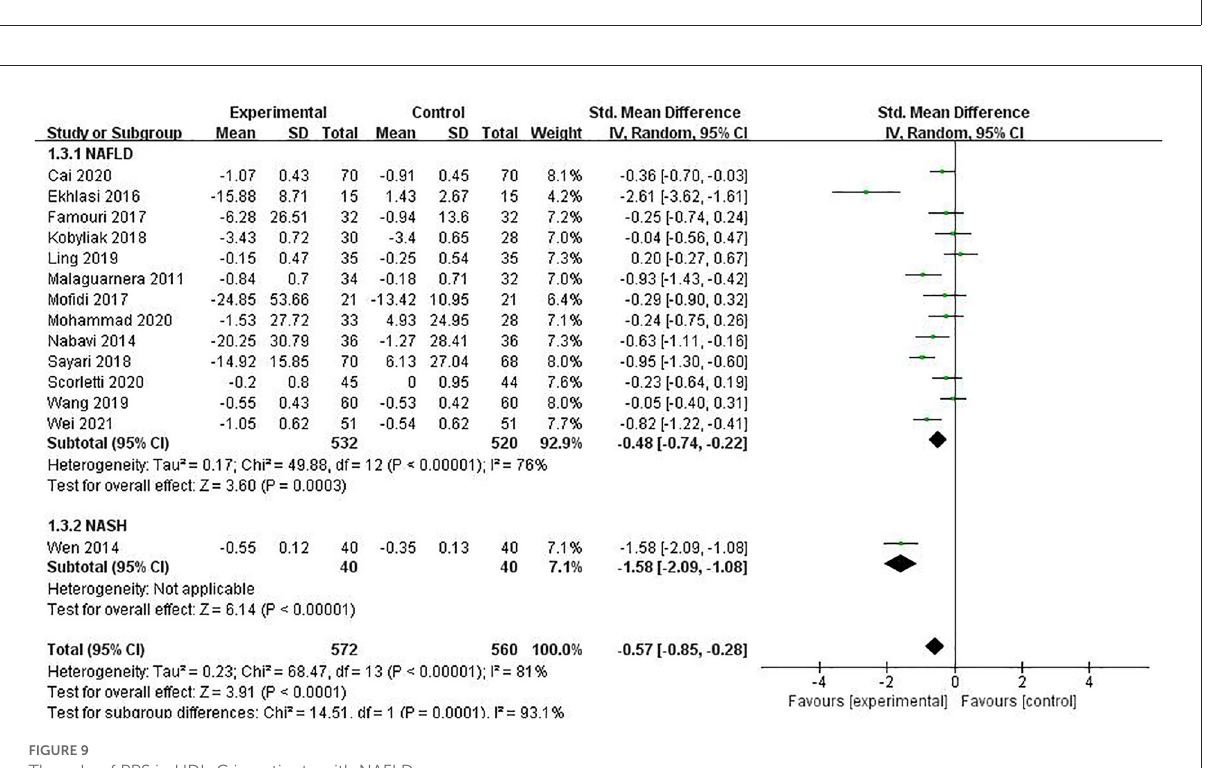
FIGURE9 The role of PPS in HDL-C in patients with